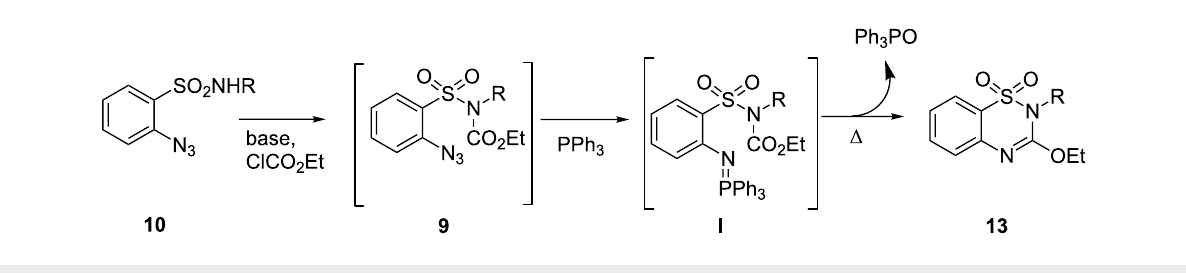
Scheme 3: Rationalization of the formation of compound 13 .